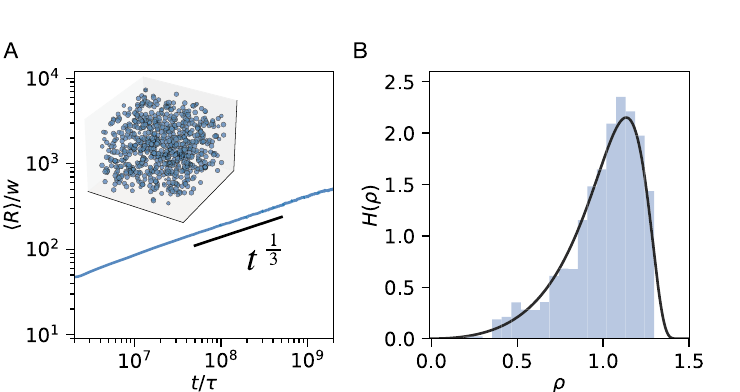
R as a function of time t shows the (cid:31) (cid:30) 2 10 8 τ . ( B ) Frequency H (ρ) of the normalized = × 3 , where L 0, L 10 4 w . We [ ] = 0 ) 0.05 . Remaining parameters are = =